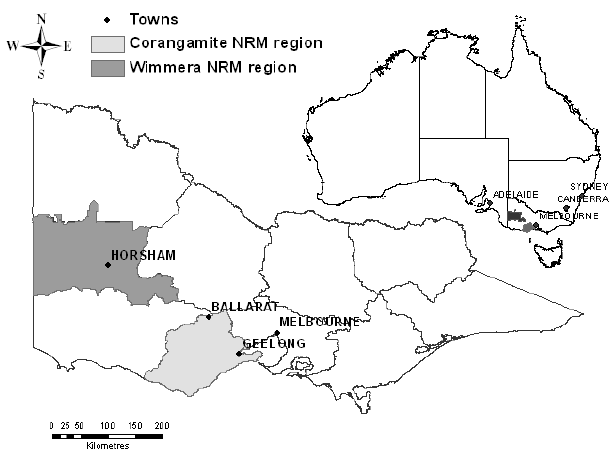
Fig. 1 . The Wimmera and Corangamite natural resource management (NRM) regions, Victoria,